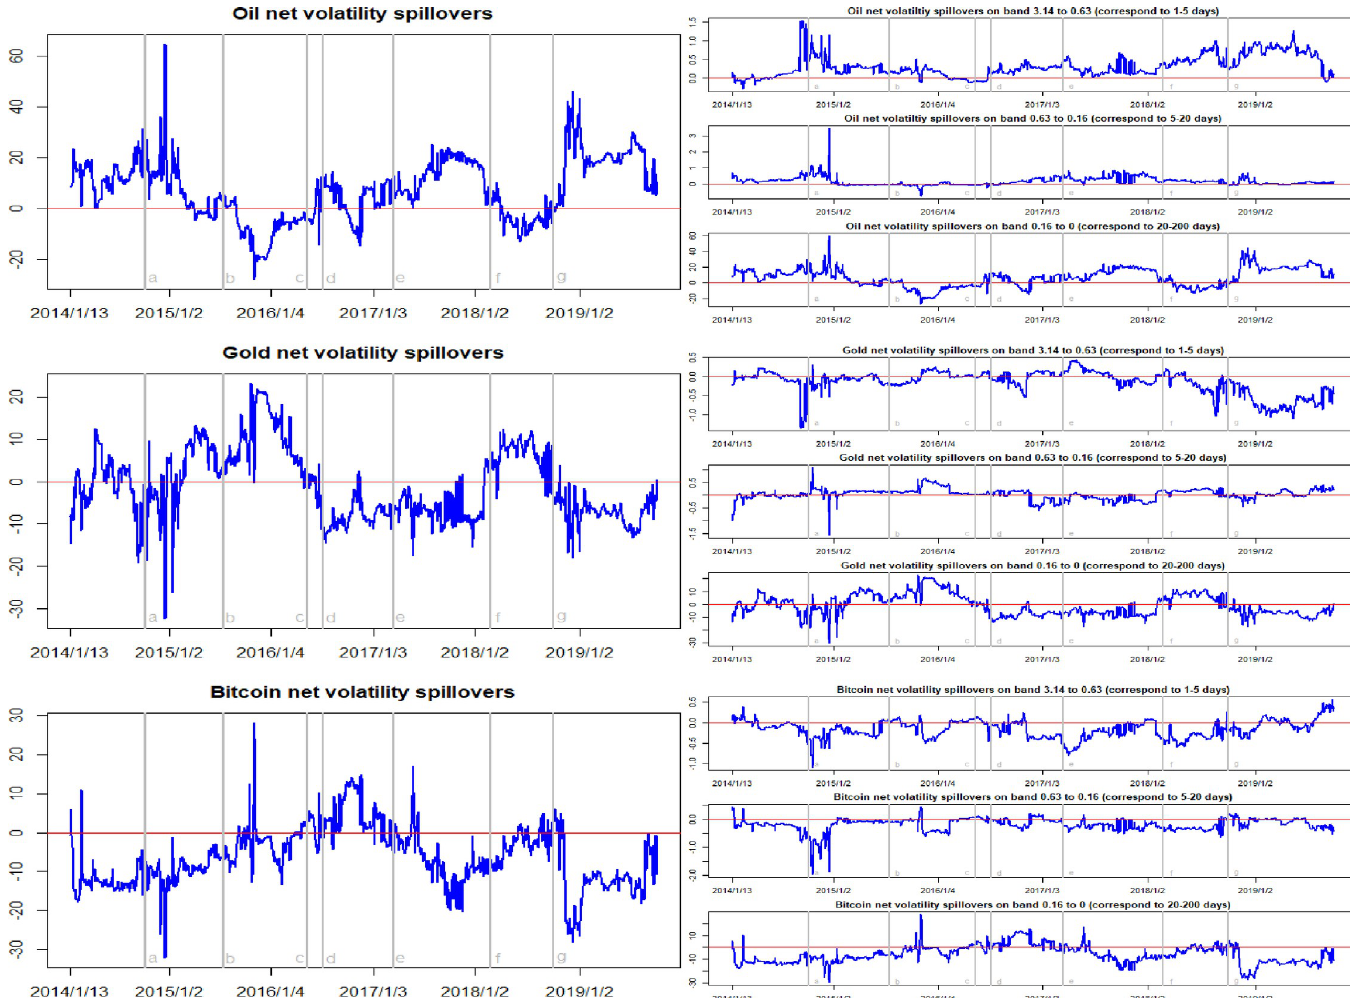
Fig 8. Time-frequency dynamics of net volatility spillovers for oil, gold, and Bitcoin. a, b, c, d, e, f, g respectively represent the seven events: the WTI oil price collapsed in October 2014, the black swan event in gold market occurred in July 2015, the sharp rise of bitcoin prices in May 2016, the Brexit event in July 2016, the expectations of a Federal Reserve rate hike in March 2017, the price of Bitcoin and gold fluctuating fall at the beginning of 2018, and the WTI oil price declines in August 2018.